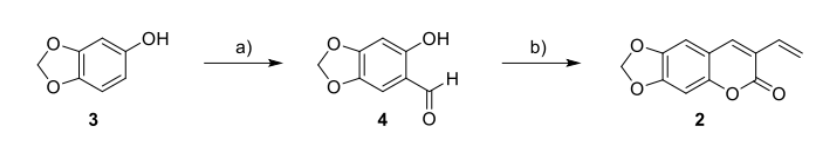
Figure 2. Reaction conditions (a) sesamol ( 3 ) (1 eq.), tin(IV) chloride (1.2 eq.), dichloromethoxymethane (1 eq.), dichloromethane (DCM), 0 ◦ C to room temperature in 3 h, acid workup with 1 m HCl, 83% (b) 4 (1 eq.), 3-butenoic acid (1.25 eq.), N,N-Dimethylpyridin-4-amine (1.25 eq.), dicyclohexylmethanediimine (1.25 eq.), Cs 2 CO 3 (1 eq.), DCM, 48 h,